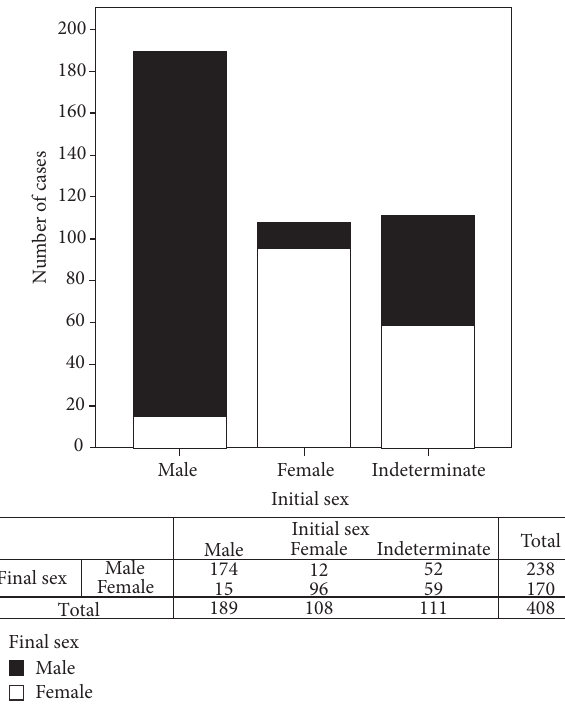
Figure 1: Distribution of initial and final sex assignments in 408 consecutive cases of DSD with ambiguous genitalia followed at GIEDDS, UNICAMP, between January 1989 and December 2011.